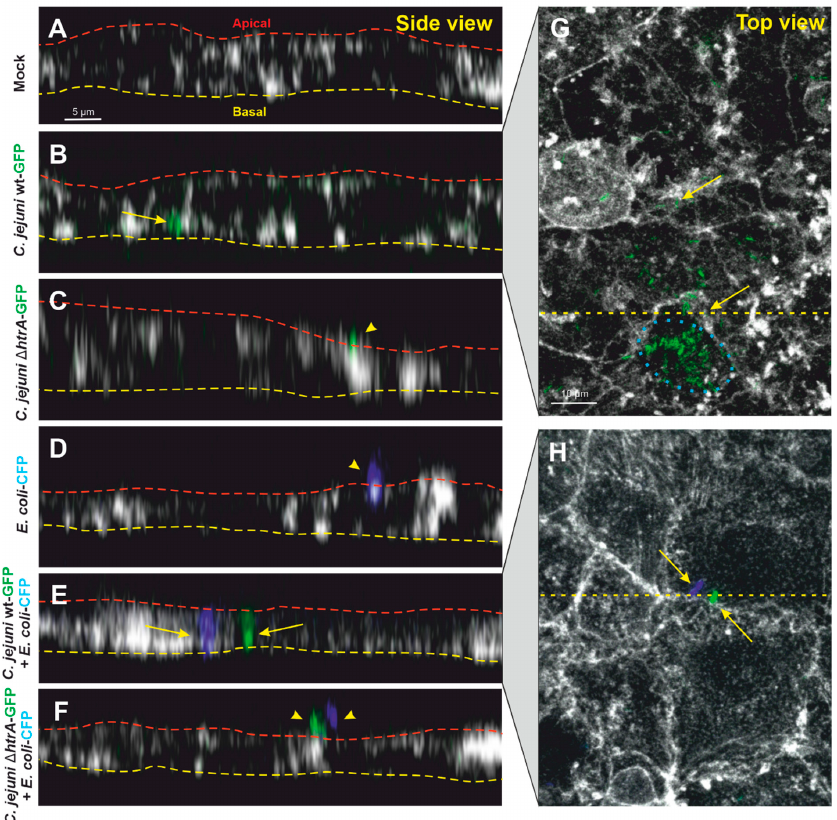
Figure 3. Side and top view of infected Caco-2 monolayers by confocal fluorescence microscopy. The cells were infected with the indicated C. jejuni and/or E. coli bacteria and counterstained with rhodamine-phalloidin to visualize the actin cytoskeleton (gray). Lateral sections (Z-orientation) are given for showing bacterial transmigration to basolateral sides of epithelial cells. Caco-2 monolayers were left uninfected ( A ) or infected with either C. jejuni -GFP wt ( B ), C. jejuni ∆ htrA -GFP ( C ) or E. coli -CFP ( D ). Dual co-infections were performed using wt C. jejuni -GFP and E. coli -CFP ( E ) or C. jejuni ∆ htrA -GFP and E. coli -CFP ( F ). The red and yellow dashed lines mark apical and basal sides of the cell monolayers, respectively. The yellow arrowheads indicate attached bacterial cells, and yellow arrows mark transmigrating bacteria from apical to basal sides. ( G , H ) Top view of enlarged sections showing the localization of transmigrating bacteria that are between neighboring cells at the basal side (yellow arrows). The images also show some intracellular C. jejuni. Examples are marked with a blue dotted circle. The yellow dashed lines indicate the corresponding cross sections. The cells were infected with an MOI of 1 to detect single bacterial